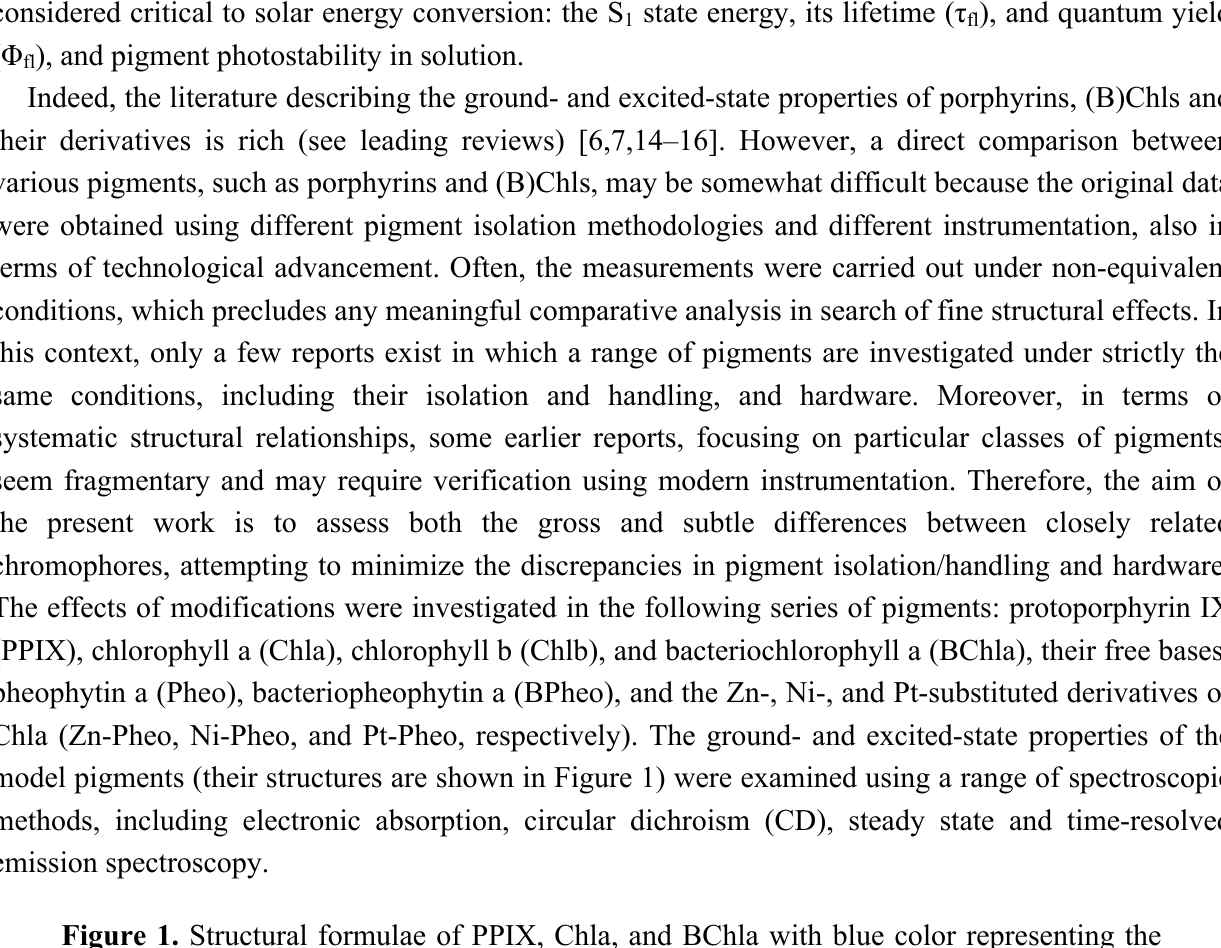
Figure 1. Structural formulae of PPIX, Chla, and BChla with blue color representing the conjugated π -electron system. The numbering system of the pyrrolenine rings is shown at PPIX, and the numbering of the carbon skeleton is shown at